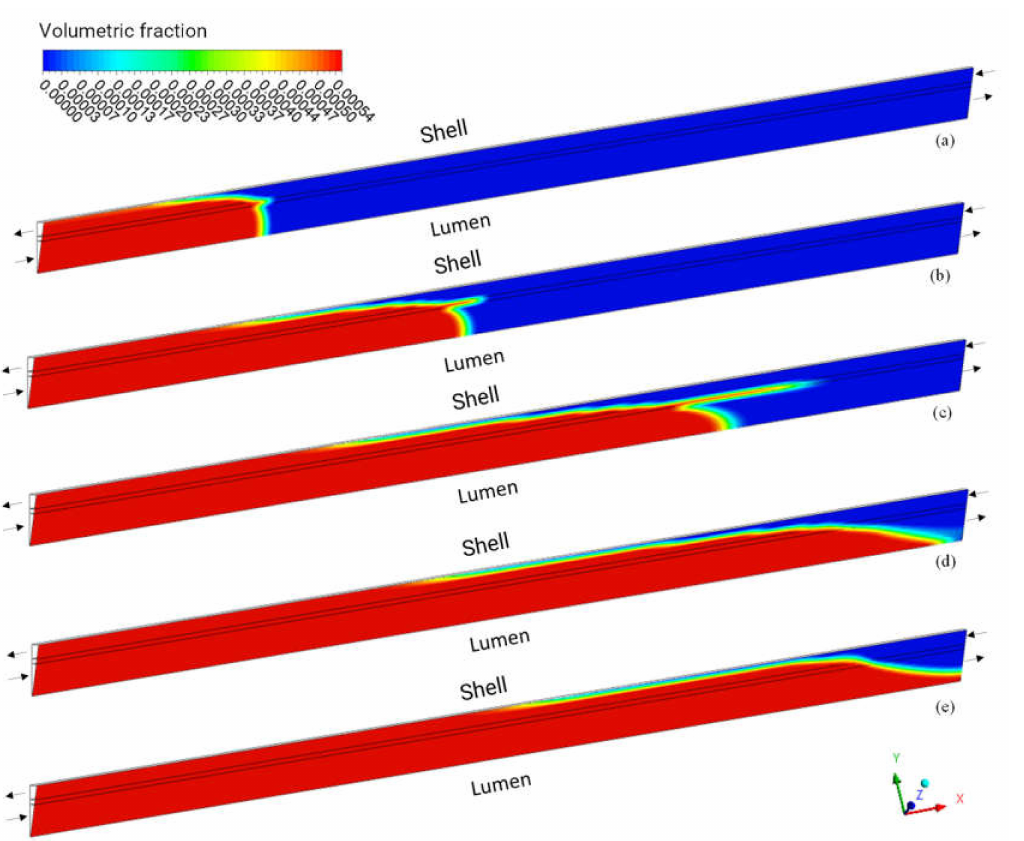
Figure 11. Distribution of the volume fraction of urea in the XY plane at Z = 0 m and different process